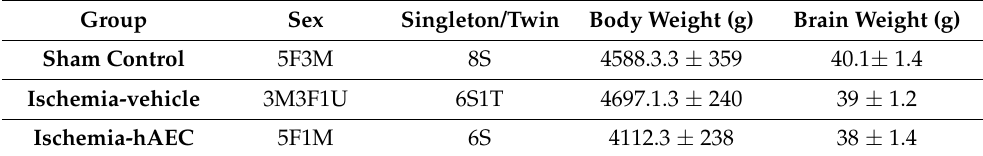
Table 1. Sex distribution, number of singletons and twins per group and post-mortem body and brain weight for the sham control (n = 8), ischemia-vehicle (n = 7) and ischemia-hAEC (n = 6) groups. F = female, M = male, U =